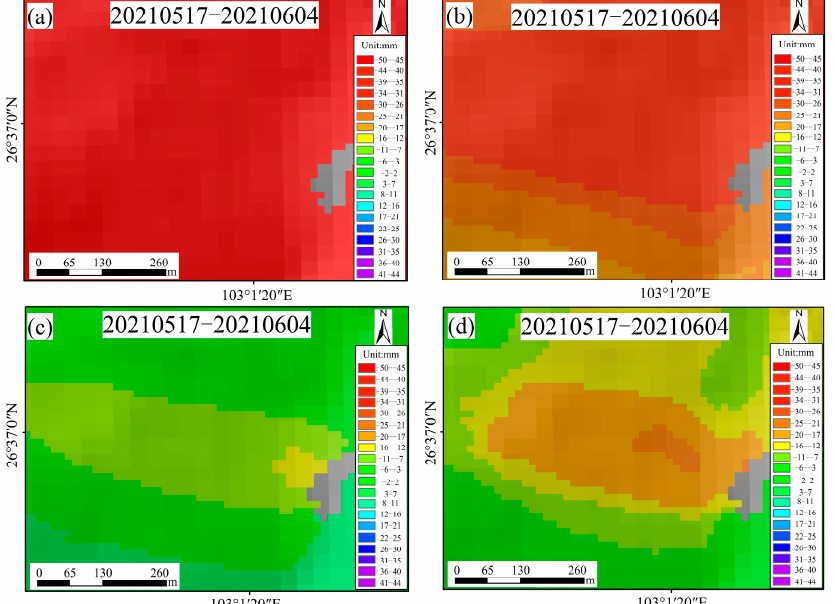
Figure 7. ( a ) Original displacement results; ( b ) displacement results after linear model correction; ( c ) displacement results after GACOS correction; ( d ) displacement results after correction of MLP neural network model.